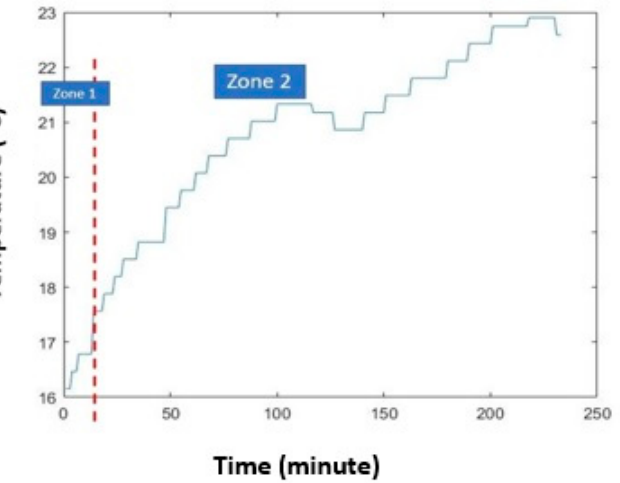
Figure 21. Indoor temperature changes in a theoretical classroom (measured values). Zone: It remarks different conditions during the experiments.